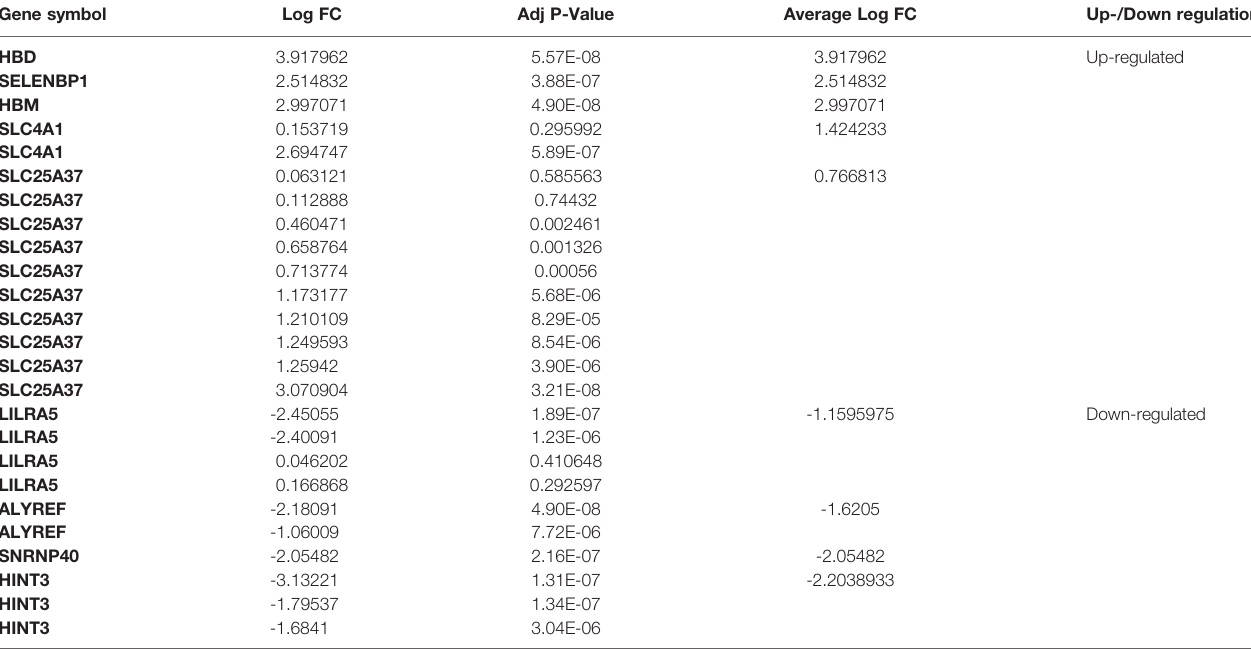
TABLE 1 | The log FC of common candidate genes.